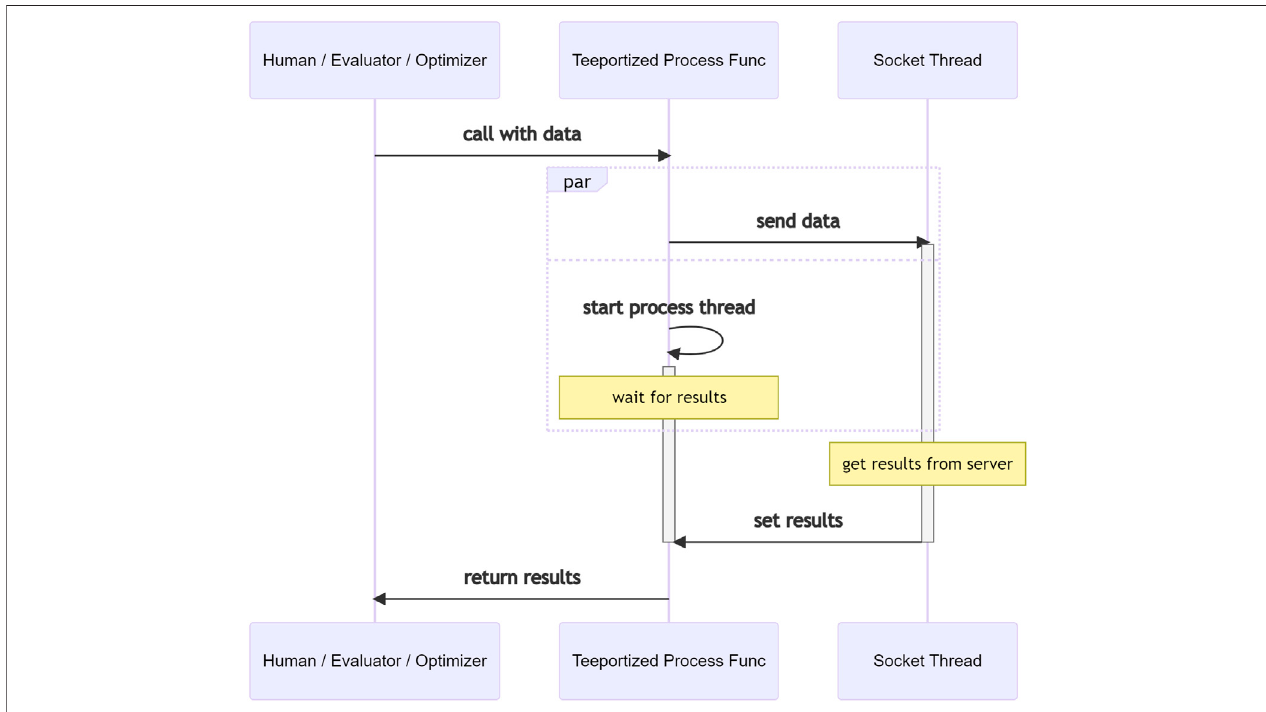
FIGURE 7 | Data- fl ow in Teeport when calling the Teeportized process function from the use_processor (id) API to get some data processed.